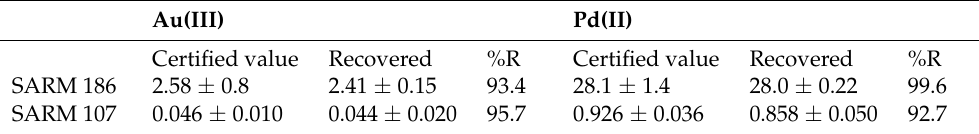
Table 5. Analytical results (mg kg − 1 ) of Pd(II) and Au(III) in the South African reference materials (SARM (186 and 107)).